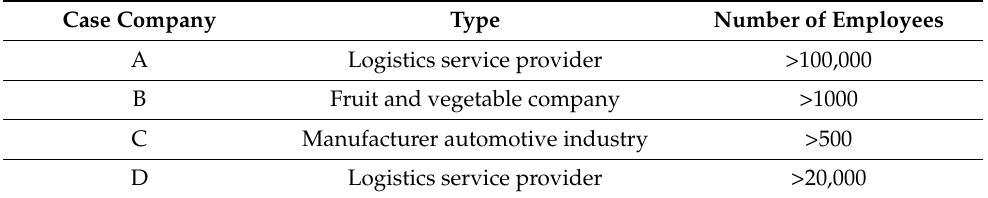
Table 1. Overview of